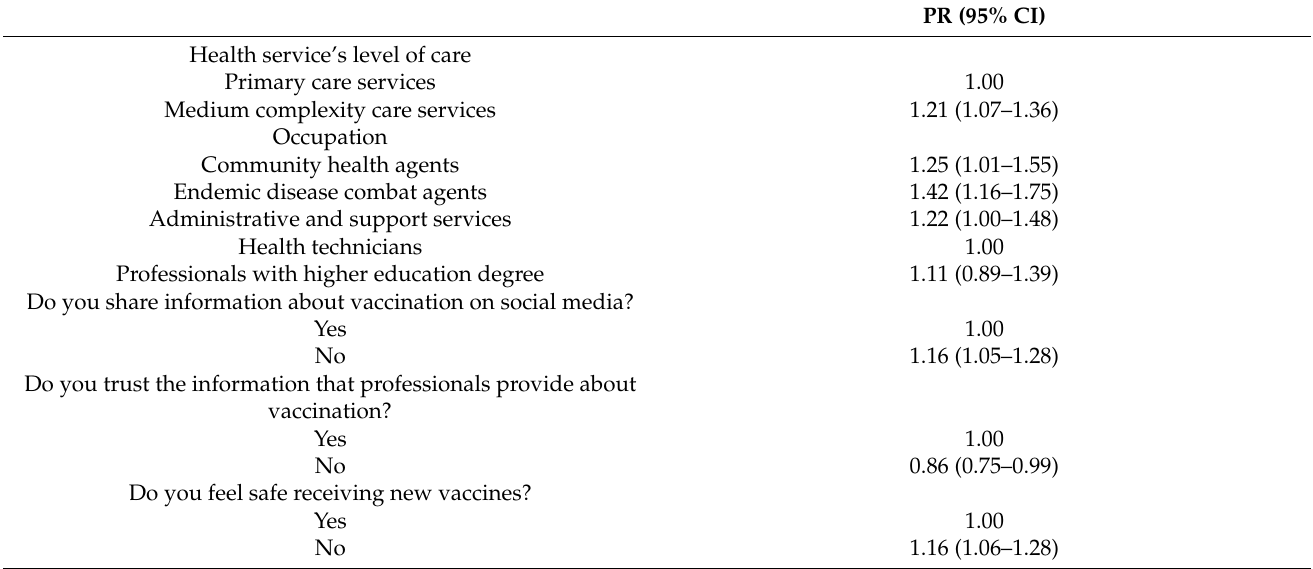
Table 5. Factors associated with vaccine hesitancy among health workers obtained in multivariate analysis in Bahia, Brazil, in